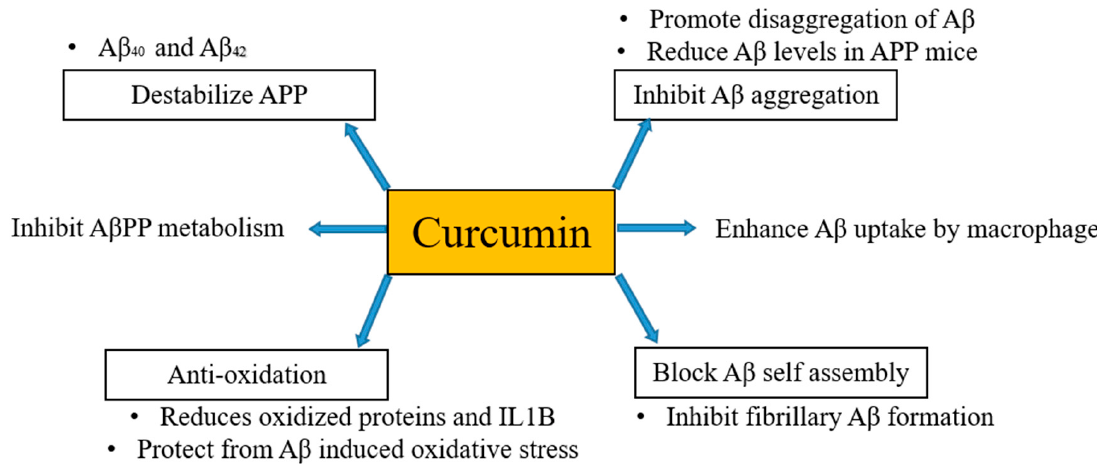
Figure 1. Anti-amyloid properties of curcumin. Curcumin regulates A β metabolism and inhibits A β aggregation in several ways.